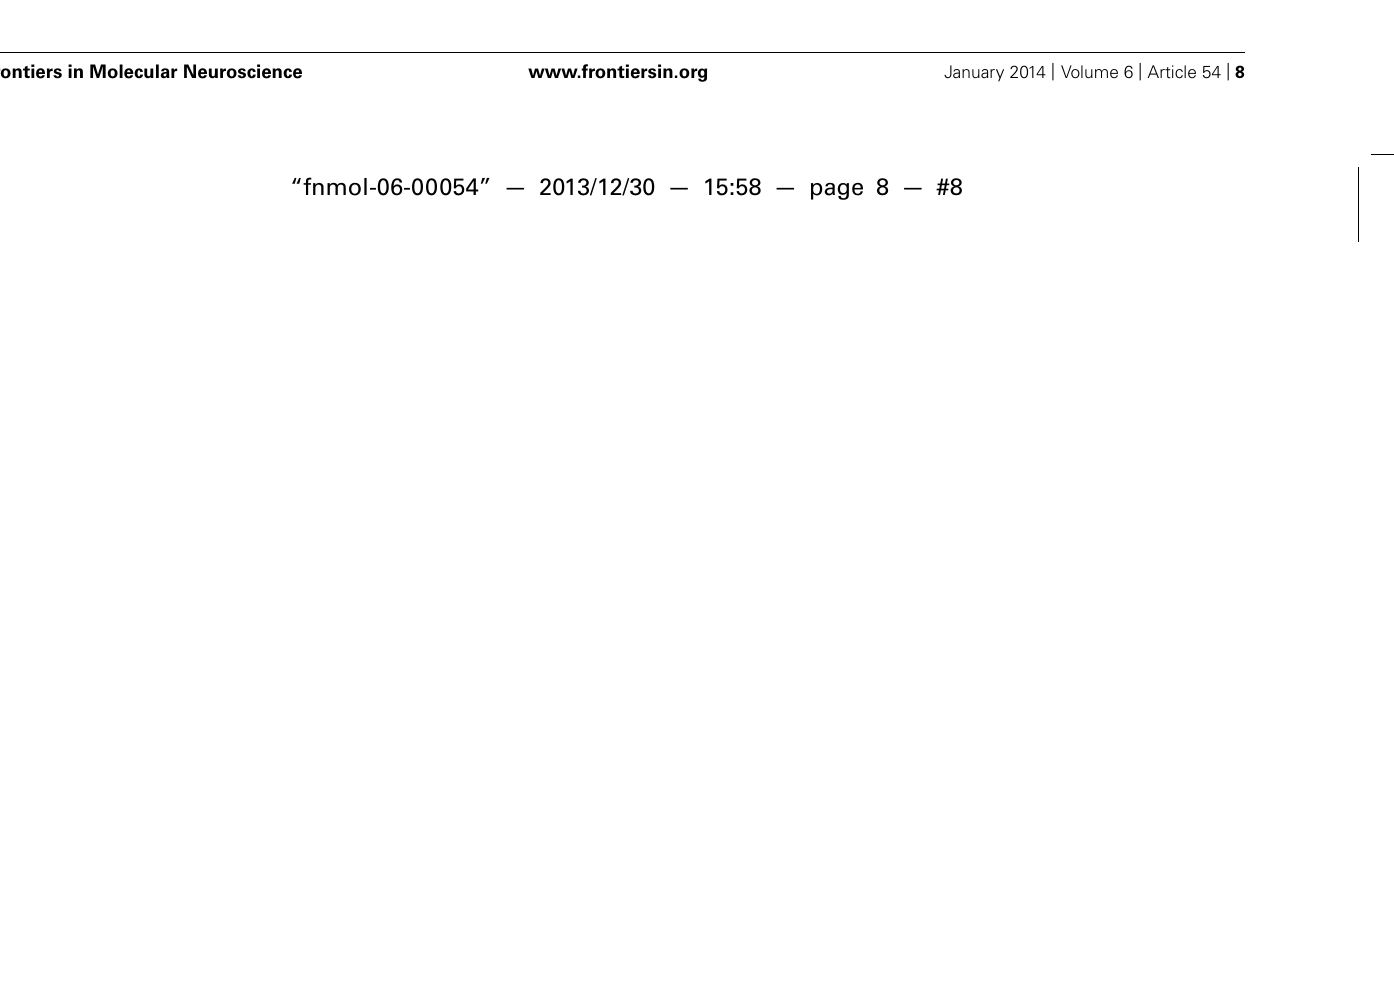
injected with PTD4-PI3KAc exhibited a statistically significant shift toward larger areas after 96 h (closed squares), but only in the small and stubby categories (Kolmogorov–Smirnov, stubby: p < 0.001, small: p < 0.01). CFC animals showed significantly larger head sizes in all three spine categories (open circles; Kolmogorov–Smirnov, p < 0.001), whereas activation of PI3K (closed circles) in CFC tested animals favored a shift toward small spine heads, as compared to CFC alone (Kolmogorov–Smirnov, p < 0.001). Scale bar: 1 μ